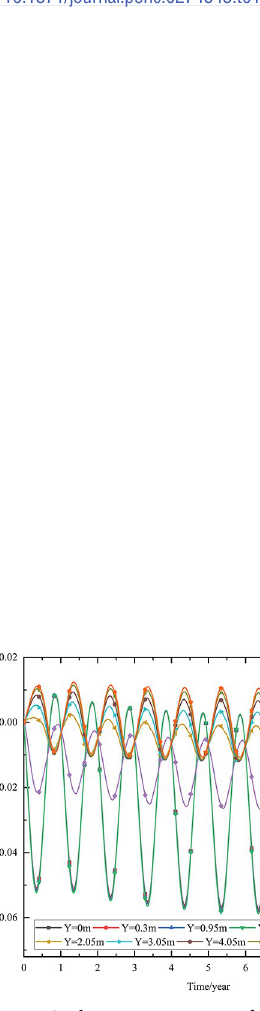
Fig 18. Settlement-time curves of pavement center under the static load of the aircraft at subbase layer thicknesses of (a) 0.10, (b) 0.30, and (c) 0.50 m.